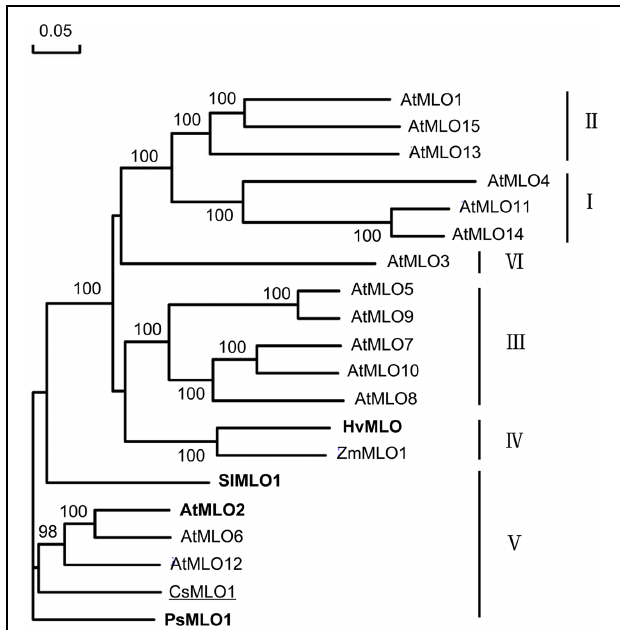
FIGURE 2 | Phylogenetic relationships of CsMLO1 and MLO proteins from other species, including HvMLO (barley), AtMLO1–AtMLO15 ( Arabidopsis ), ZmMLO1 (maize), SlMLO1 (tomato) and PsMLO1 (pea). The six clades were designated according to Devoto et al. (2003). Proteins that have been proven to play an important role in powdery mildew (PM) resistance are highlighted in bold; cucumber CsMLO1 is underlined. Numbers at the nodes indicate bootstrap support based on 1000